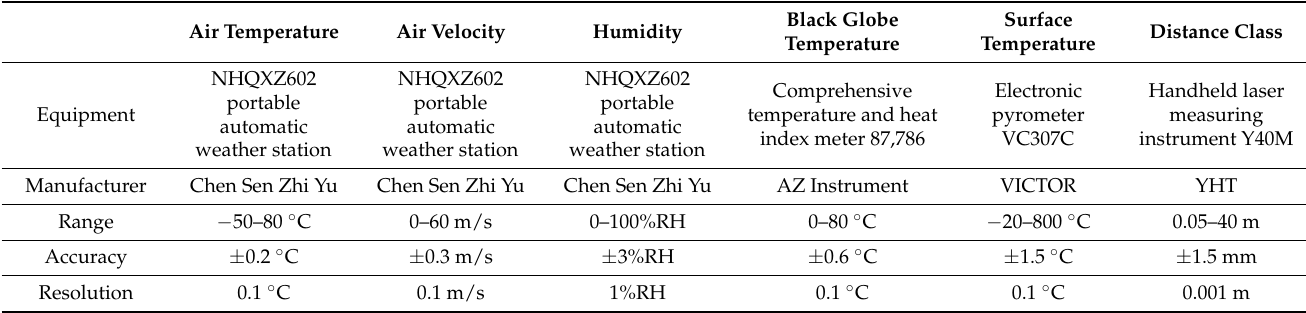
Table 2. Instrument measurement range and accuracy.